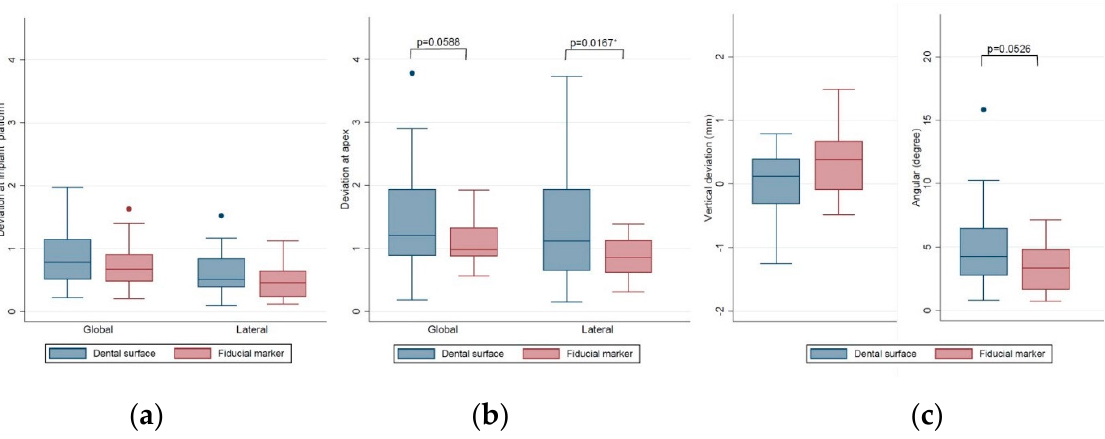
Figure 9. Box plots of the deviations of surface registration protocol (blue) and fiducial marker registration protocol (red). ( a ) The global and lateral deviations at the implant platform, ( b ) global and lateral deviations at the implant apex, and ( c ) the depth and angular deviations.